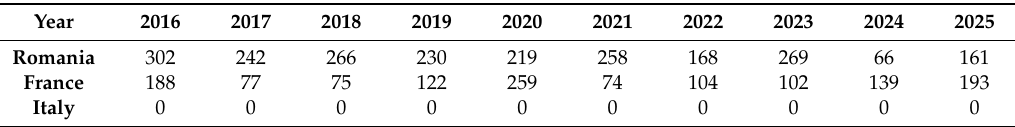
Table 5. The estimation of bioethanol potential from potatoes (million liters of absolute alcohol). Source: authors’ own calculation based on